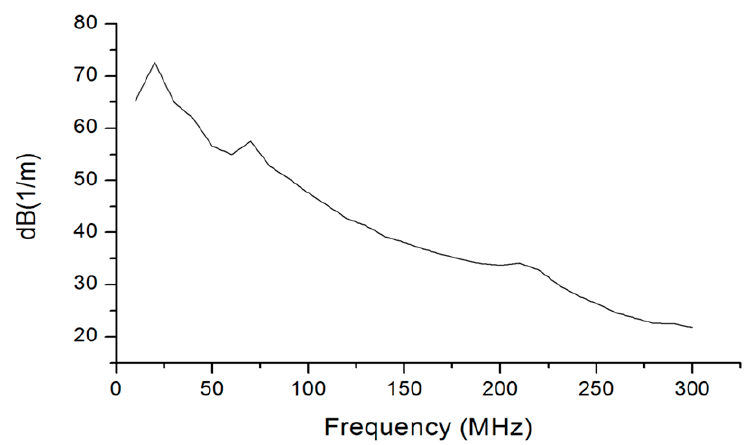
Figure 4. Simulated antenna factors for 0.3 m dipole with coaxial balun. The antenna model was simulated in HFSS.